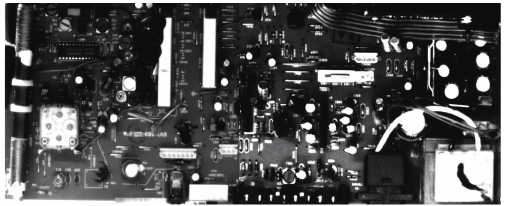
Figure 9: The PWB of a radio and its supported components.